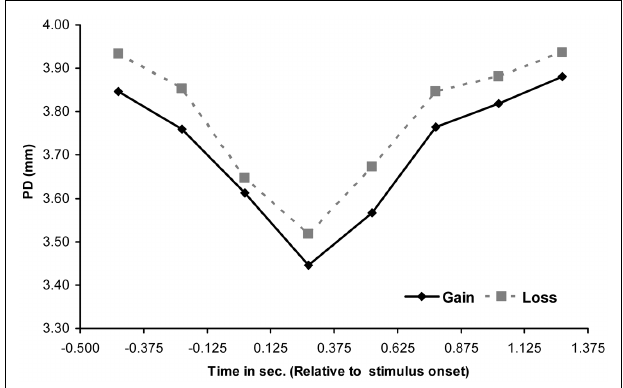
FIGURE 1 | Mean pupil diameter in the Loss and Gain conditions (in mm) across participants and events (of loss: − 600 or − 1200, or of gain: 600 or 1200). Time zero denotes the outcome presentation